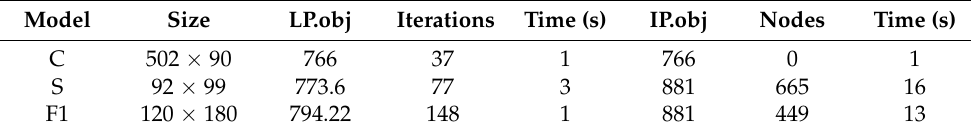
Table 2. Computational